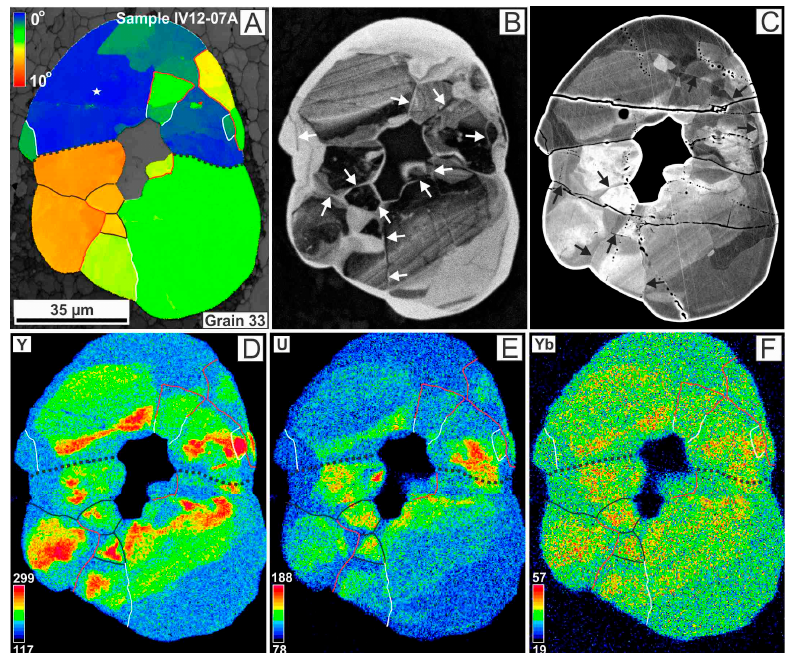
Figure 2. Images of the zircon grain 33, sample IV12-07A. ( A ) Cumulative misorientation EBSD map, showing the orientation of every data point with respect to a reference point (white star). Misorientation varies from 0 (blue) to 10° (red). ( B ) Panchromatic CL image, arrows point to dark and bright features that spatially correspond to low angle boundaries. ( C ) BSE image of the grain, arrows as in B. ( D ) Qualitative chemical map of Y distribution derived with FEG-EMPA. ( E ) Qualitative chemical map of U distribution derived with FEG-EMPA. ( F ) Qualitative chemical map of Yb distribution derived with FEG-EMPA. Color-coding in D-F indicates the number of counts, different for each map. Superimposed lines in A, D, E, and F indicate positions of low-angle boundaries; white lines correspond to <2° of misorientation between the subgrains, red lines correspond to 2–5° of misorientation, solid black lines correspond to 5–15° of misorientation, thick black dotted lines highlight open fractures that produce misorientation.